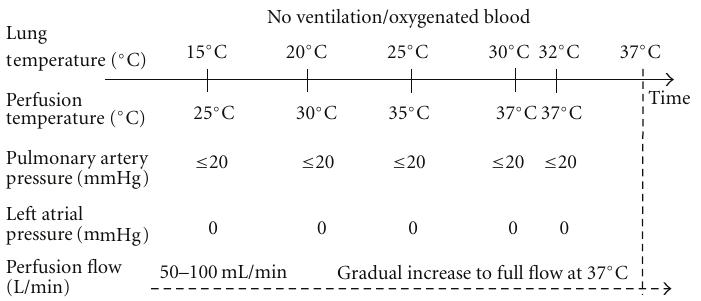
Figure 3: Flowchart showing the second part of the ex vivo reconditioning of donor lungs initially rejected donor lungs for clinical transplantation. During the second part of the process, the lungs are ventilated and the perfusate blood is oxygenated. When the temperature reaches 32 ◦ C, careful ventilation is started at 1 L/min. The ventilation rate is increased with one liter per increasing degree of perfusate from the lung (i.e., increasing lung temperature). The FiO 2 was maintained at 1.0, and the respiratory frequency was gradually increased from 5 to 15–20 per min. The perfusion flow was limited by the pulmonary pressure ( ≤ 20mmHg). The PEEP was gradually increased to 5cm H 2 O at 37 ◦ C.